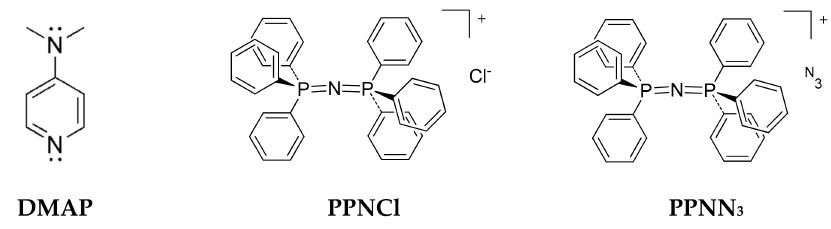
Scheme 3. Structures of co-catalysts utilized for the copolymerization reactions.